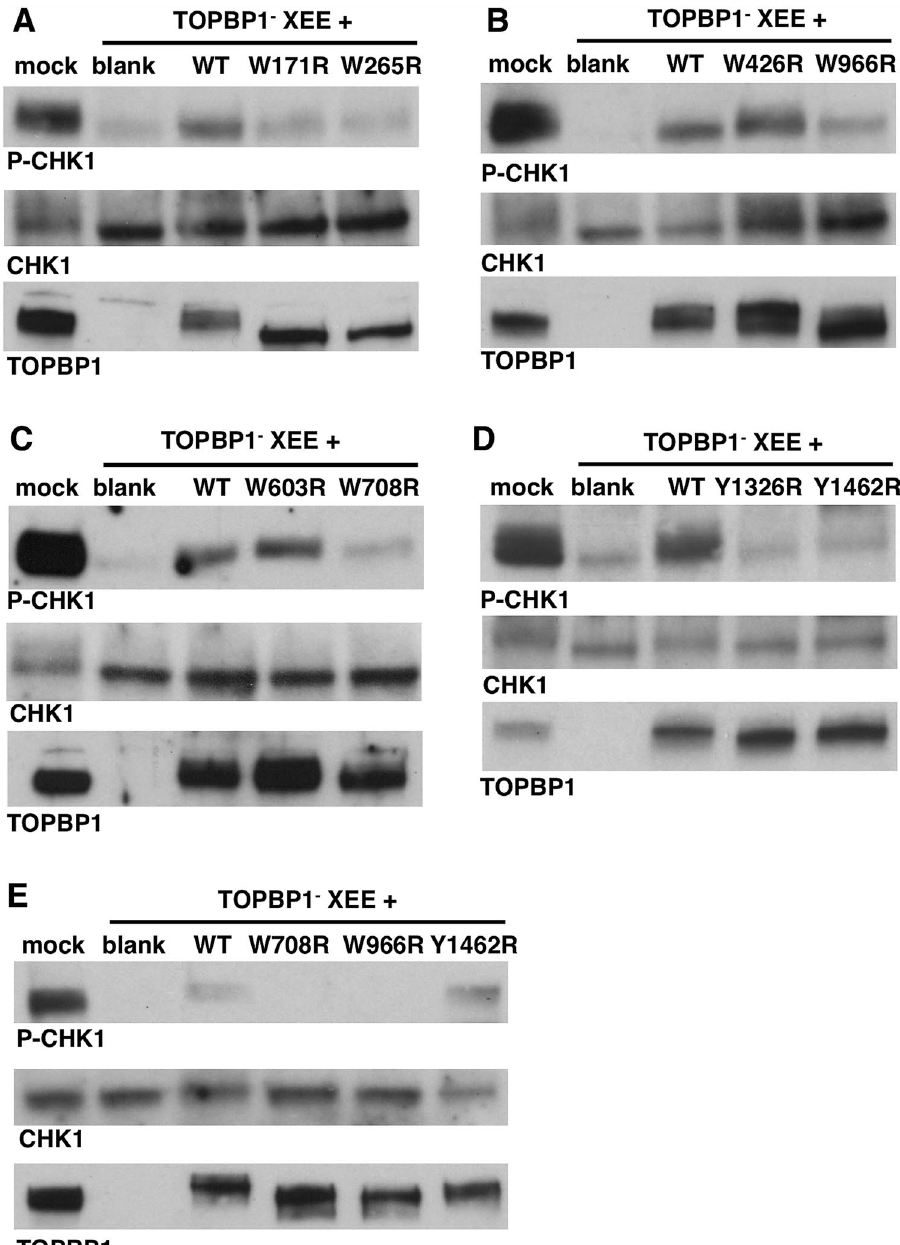
Figure 6. Multiple TOPBP1 BRCT domains are required for ATR-directed phosphorylation of CHK1. A−E DMAX assays where HSS was depleted of endogenous TOPBP1 and then supplemented with the indicated IVTT-produced TOPBP1 mutants prior to the addition of DSBs. Mock refers to extract that was mock-depleted using non-specific IgG. Blank refers to a TOPBP1-depleted extract that received an unprogrammed IVTT reaction. After incubation, the samples were probed by Western blotting for P-CHK1, CHK1, and TOPBP1 (using anti-TOPBP1 antibody